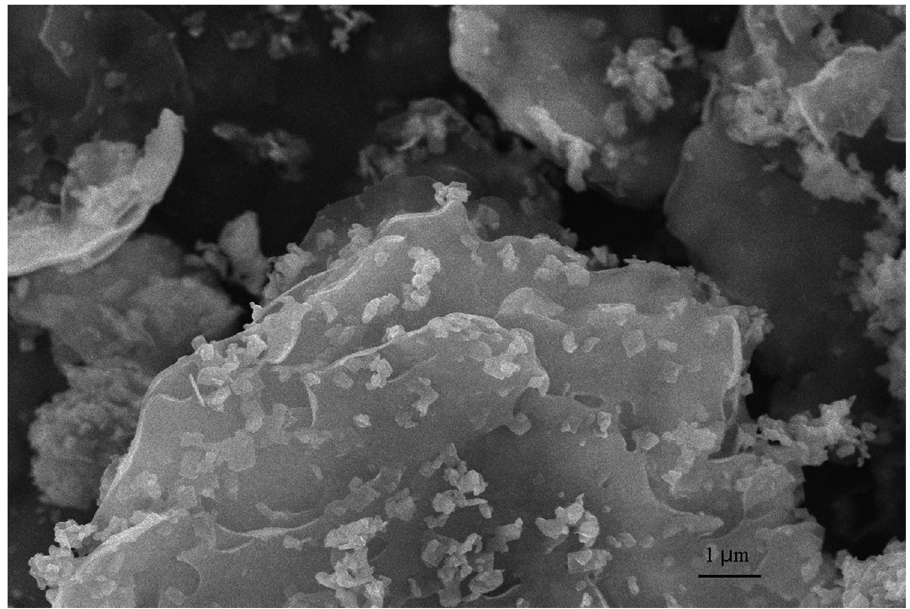
Figure 1: SEM micrograph of the surface of the Zn – Co DMC complex